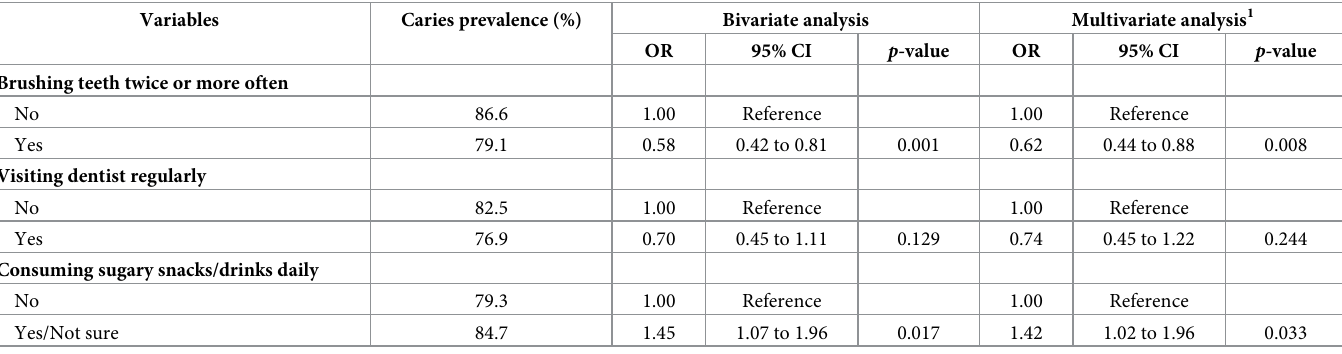
Table 1. Associations between dental caries status and oral health behaviors. Variables Caries prevalence